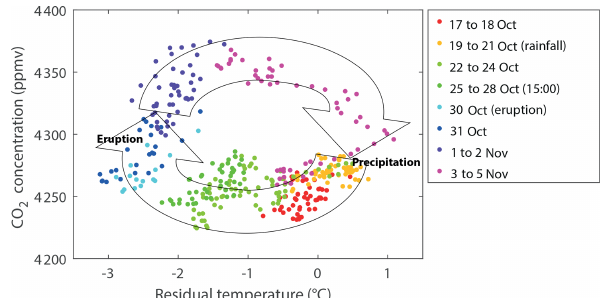
Figure 6. Evolution plot of the CO 2 mixing ratio versus the gas temperature measured at a Lascar fumarole from 17 October to 5 November 2015. The distinctively colored dots represent key stages in the evolution of these parameters characterized by a clock- wise behavior. This cyclic behavior was induced by precipitation event P3 (19–21 October; orange dots), causing (1) the gas outlet temperature to decrease following the rainfall event and (2) the CO 2 mixing ratio and outlet temperature to gradually rise after the erup- tion (30 October; cyan dots). The cycle closes during the period of 3–5 November (magenta dots), during which the CO 2 concentration and gas outlet temperature returned to their pre-eruptive